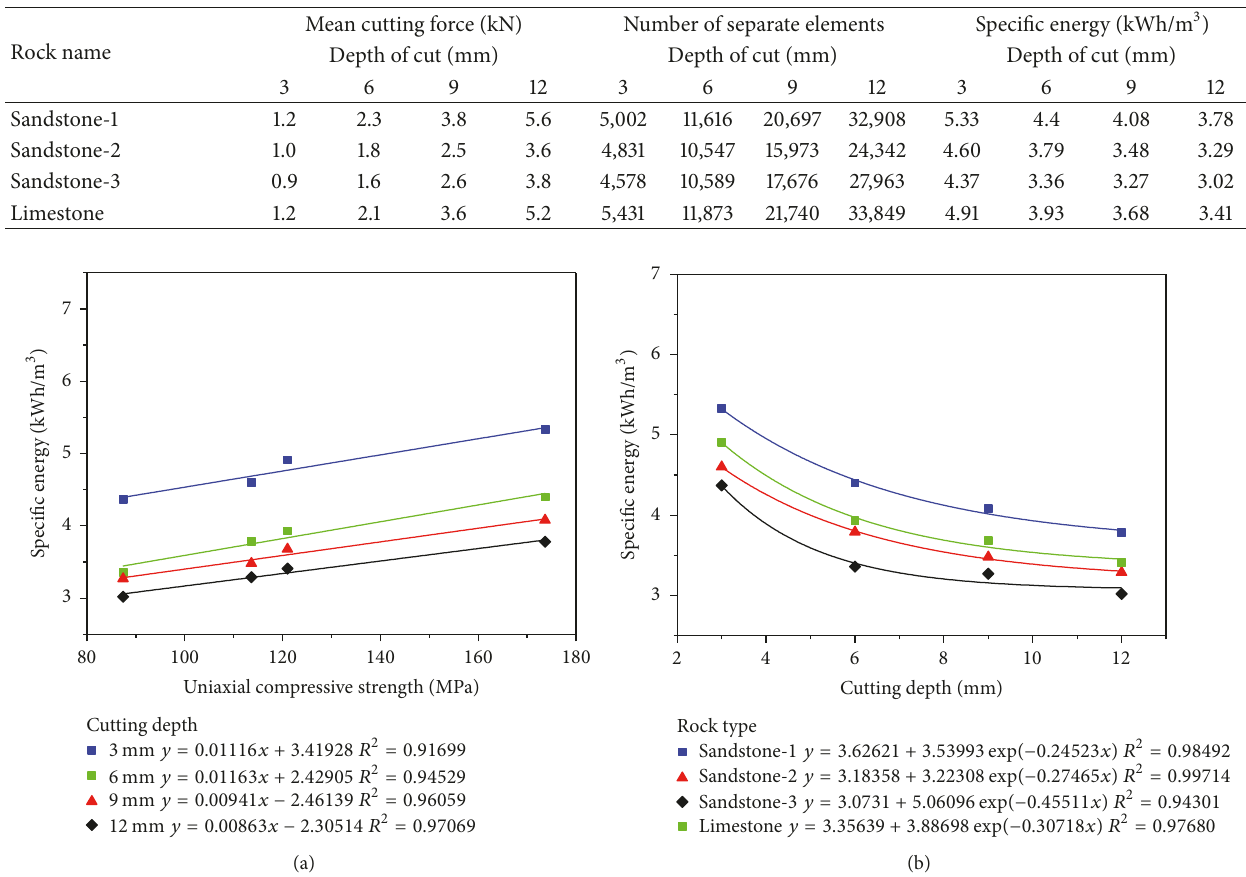
Table 6: The results of the mean cutting forces and element separation at a cutting speed of 1m/s.